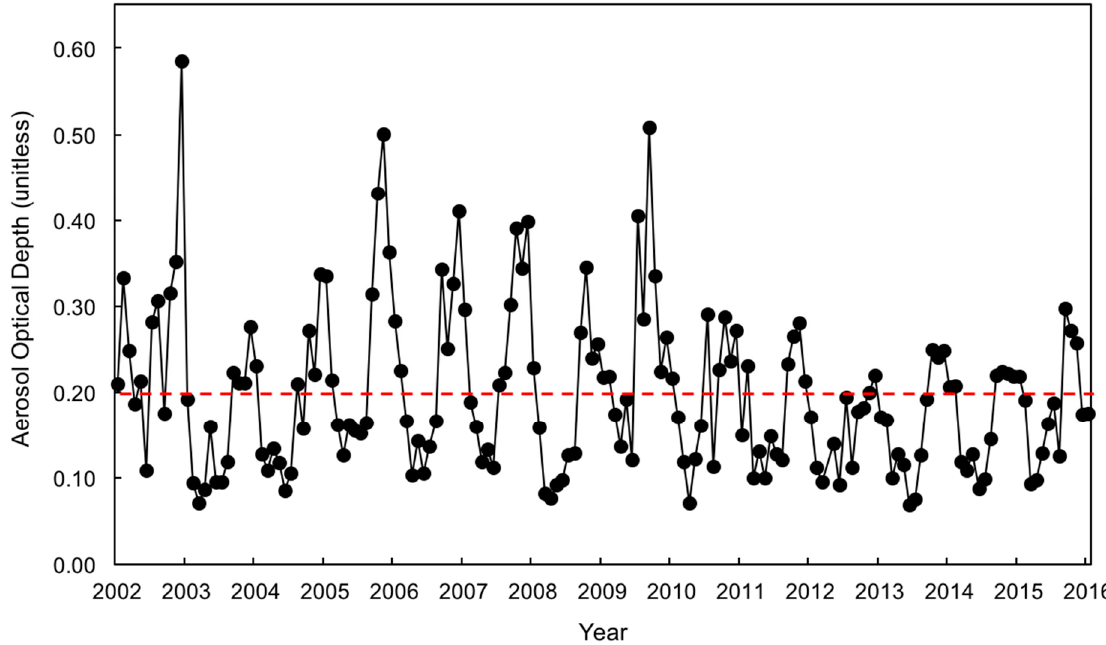
Figure 4. Remotely sensed dust assessment, derived from MODIS aerosol optical depth (AOD) data from 2002 to 2016. Low values represent a clear atmosphere, and high values represent a dusty atmosphere. A value of 0.2 (red dotted line) represents a satisfactory level of atmospheric dust [42]. Year tick marks are placed on the month of July of each year.